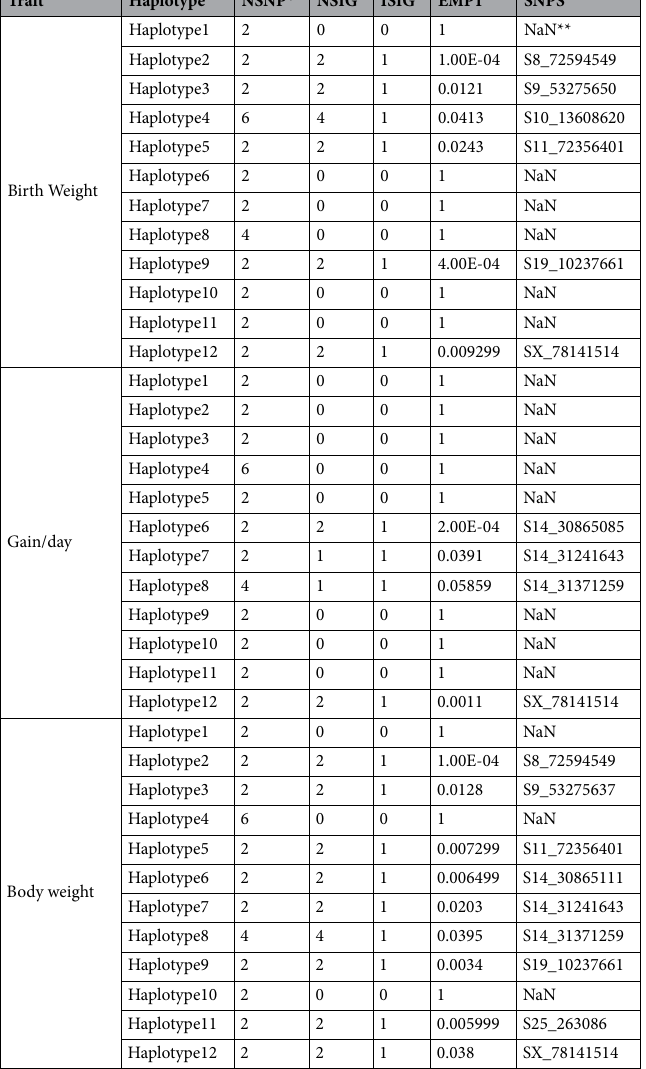
Table 6. the haplotype-traits association analysis. * NSNP: Number of SNPs in Haplotype, NSIG: Total number of SNPs below p-value threshold (p < 0.05)), ISIG: Number of significant SNPs also passing